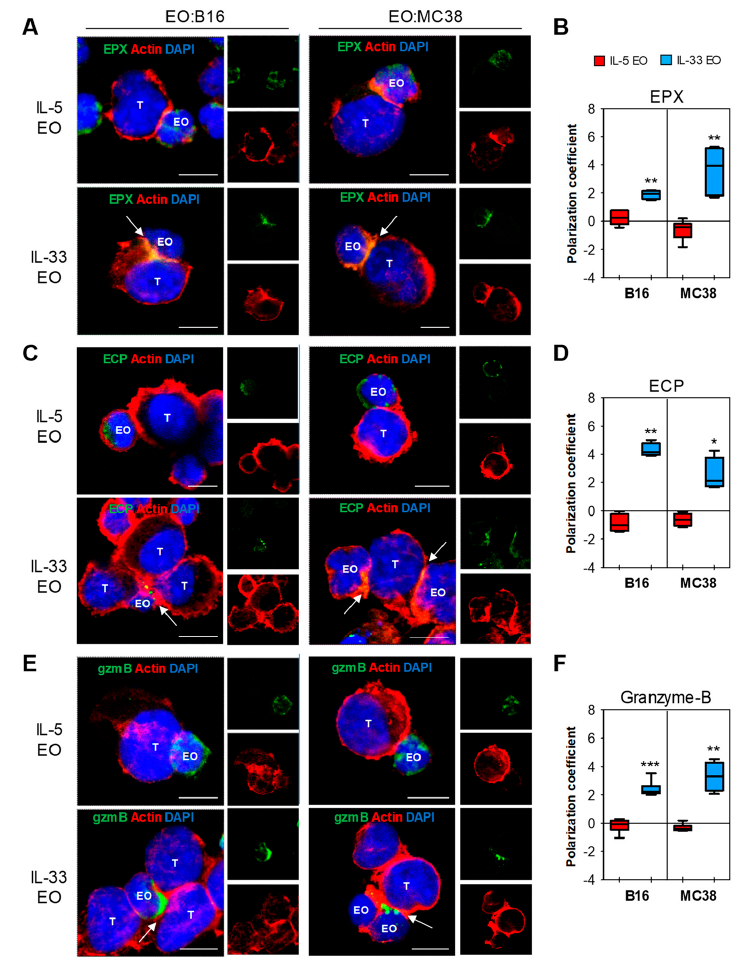
Figure 4. Polarization of granule proteins at immune synapses in IL-33 activated eosinophils. ( A , C , E ) CLSM observations of EO-tumor cell conjugates (central optical sections). IL-5 EO or IL-33 EO were allowed to conjugate with B16 (left panels) or MC38 (right panels) tumor cells. Cell conjugates stained for EPX ( A ), ECP ( C ) or granzyme-B (GzmB) ( E ) expression, all detected in green. Actin staining was performed with Alexa Fluor ® -594 phalloidin (red). Nuclei are reported in blue (DAPI). Co-localization of granule-derived proteins and actin at immune synapses of IL-33 EO is shown in merged images, detected in yellow and indicated by arrows. Inserts represent separate channel images. Scale bars, 10 µ m. Representative examples of 5 independent experiments are shown. ( B , D , F ) Quantitative determination of protein polarization to the immune synapses by ImageJ software. Data are expressed as the mean polarization coe ffi cient of several images depicting cell conjugates from 5 independent experiments ± SD. * p < 0.05, ** p < 0.01, *** p <